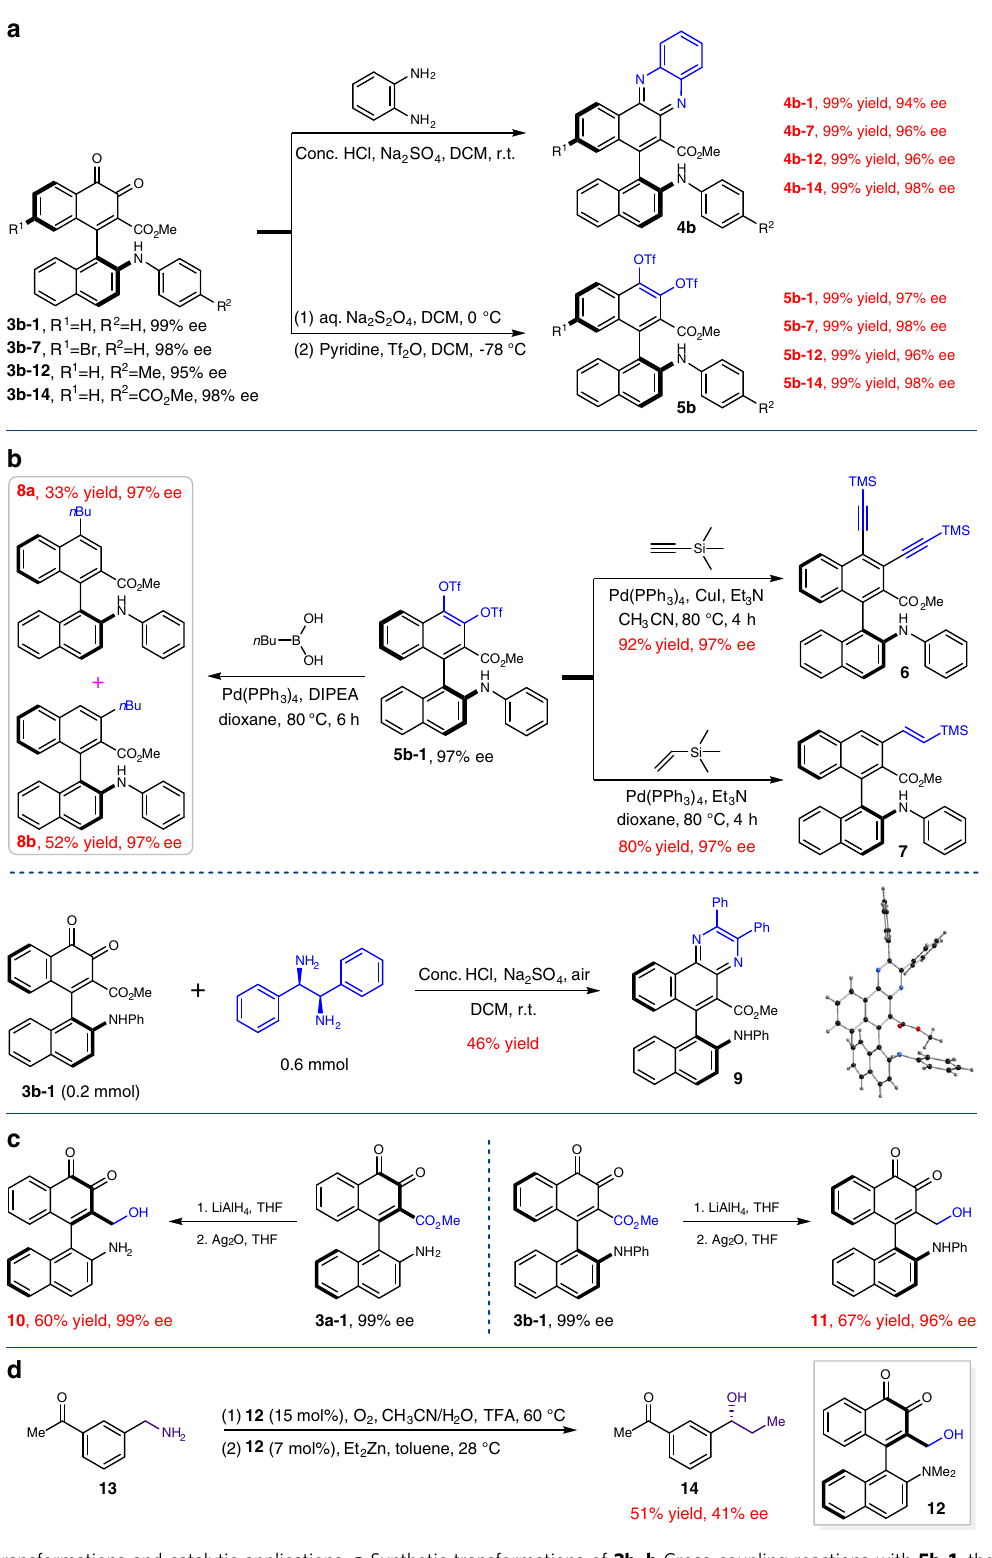
Fig. 2 Synthetic transformations and catalytic applications. a Synthetic transformations of 3b . b Cross-coupling reactions with 5b – 1 , the synthesis of compound 9 and its X-ray structure. c The reduction of the ester group on 3a – 1 and 3b – 1 . d Applications in asymmetric